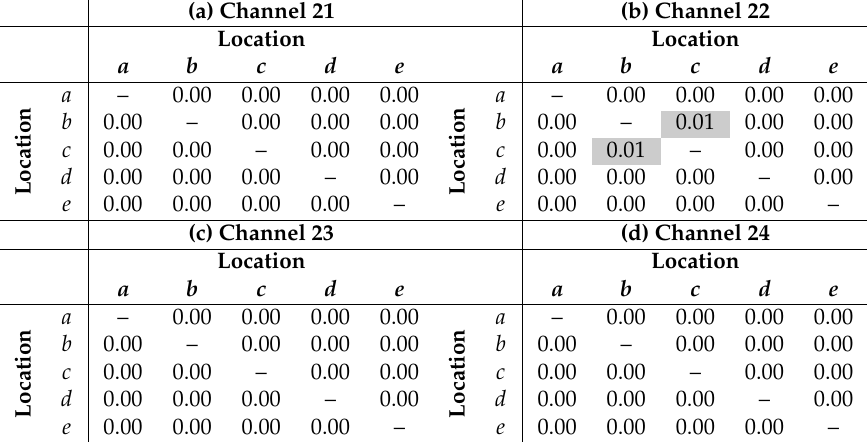
Table 1. p -values of Welch’s two-sample t -tests that check similarity of distributions of RSS measured at different locations.